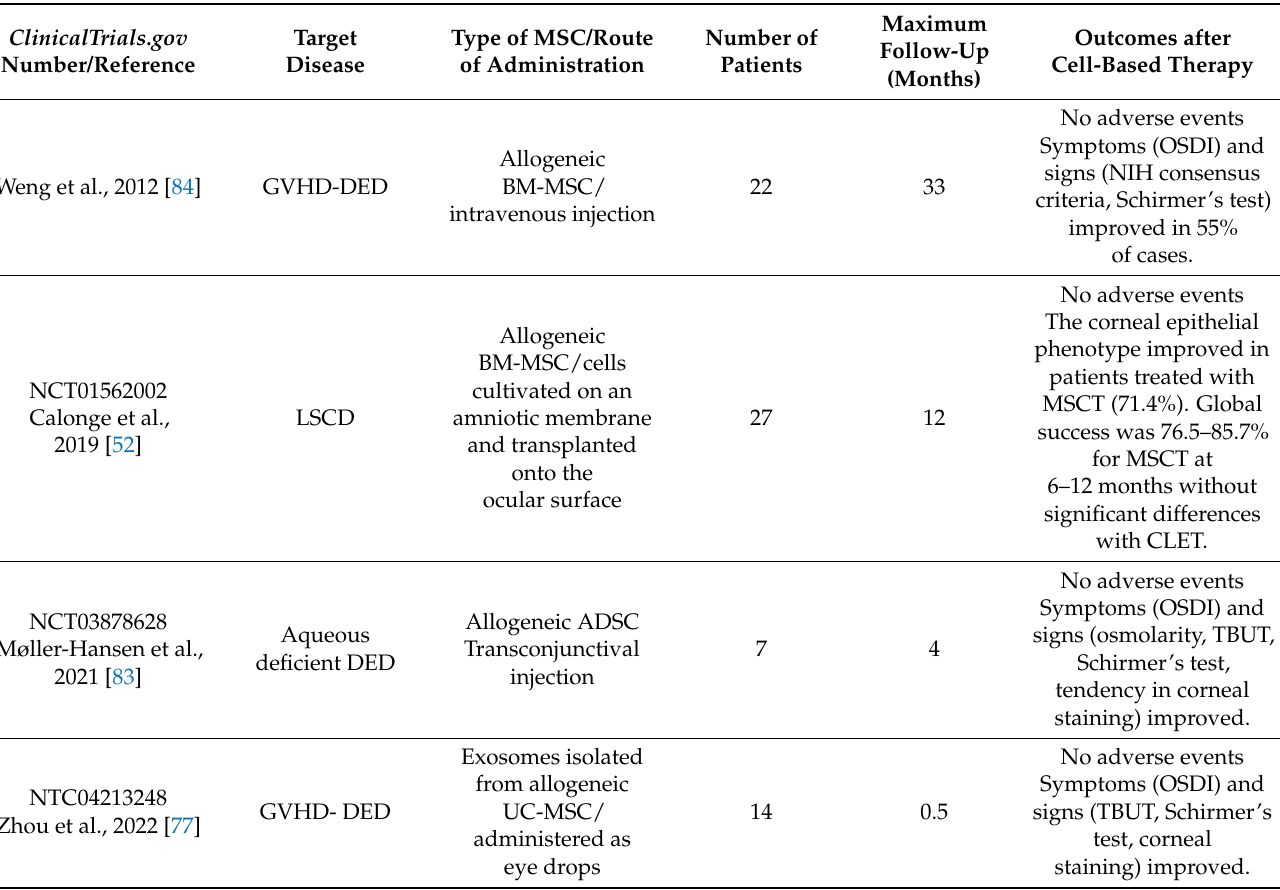
Table 2. Clinical trials in which damaged ocular surface epithelium was treated with mesenchymal stem cells (MSC)-based therapy or MSC-derived extracellular vesicle-based therapy. Only clinical trials with published results were included. Abbreviations: ADSC, adipose tissue-derived stem cells; BM, bone marrow; CLET, cultivated limbal epithelial transplantation; DED, dry eye disease; GVHD- DED, dry eye disease associated with graft-versus-host disease; LSCD, limbal stem cell deficiency; MSC, mesenchymal stem cells; NIH, National Institute of Health; OSDI, Ocular Surface Disease Index; UC, umbilical